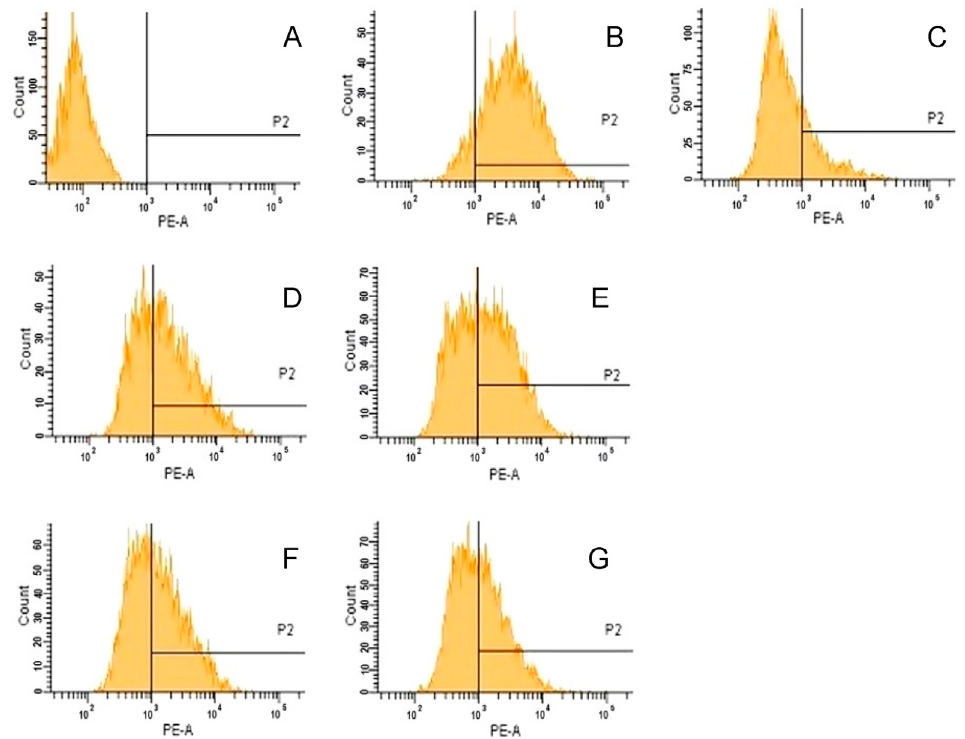
Figure 4. Flow cytometry analysis of oxidative-stressed Caco-2 cells ( B ) pretreated with 100 µg/mL of intestinal digestion products PS-BP ( D ), PS-BCM ( E ), PC-BP ( F ) and PC-BCM ( G ), for 24 h. Untreated cells ( A ) and cells treated with 12 µM ascorbic acid ( C ) served as a control. Table 3. Quantification of ROS production in oxidative stressed Caco-2 cells (B) treated with 100 µg/mL of intestinal digestion products PS-BP (D), PS-BCM (E), PC-BP (F) and PC-BCM (G), per- formed by flow cytometry. Untreated cells (A) and cells treated with 12 µM ascorbic acid (C) served as a control. The results are expressed as mean ± SD ( n = 3). * p < 0.05, compared to the oxidative stressed group; # p < 0.05, compared to ascorbic acid-treated group.